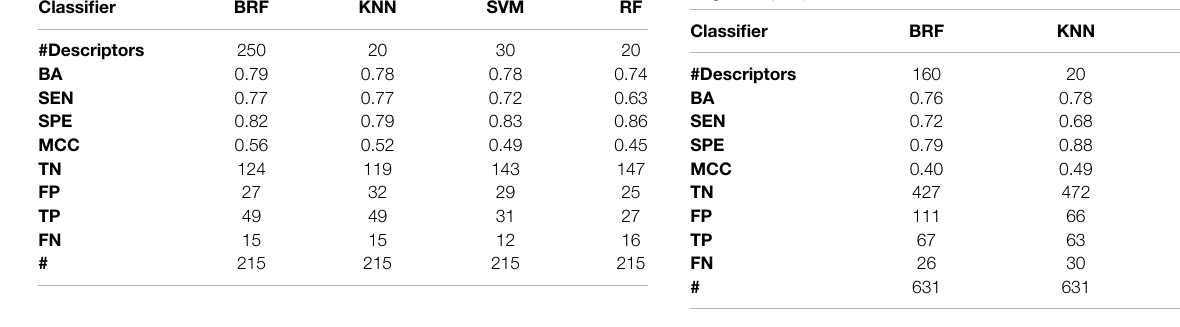
TABLE 6 | Comparison of the performance of the BRF and KNN, and ensemble models based on the HSE/INA splitting schemes on the ES. For each model, the following statistics are reported: Balanced Accuracy (BA), Sensitivity (SEN), Speci fi city (SPE), Matthews Correlation Coef fi cient (MCC), number of